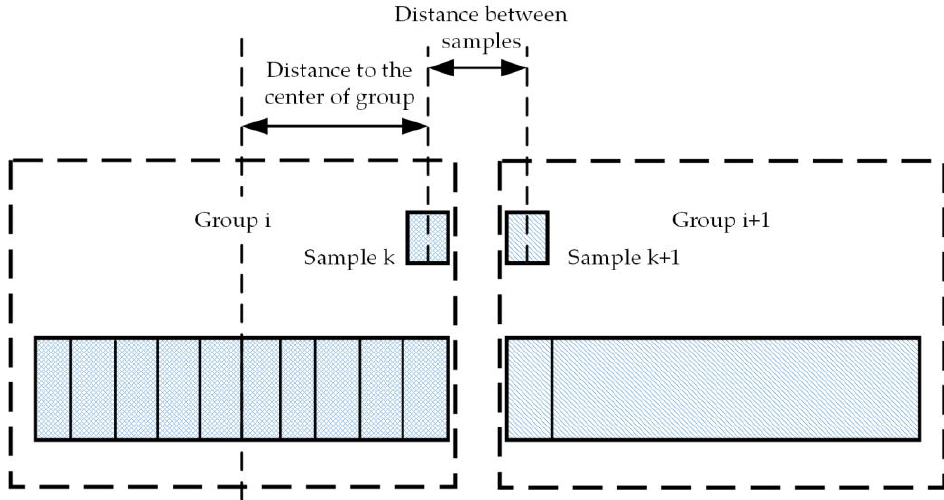
Figure 7. Shortcoming of continuous block grouping.